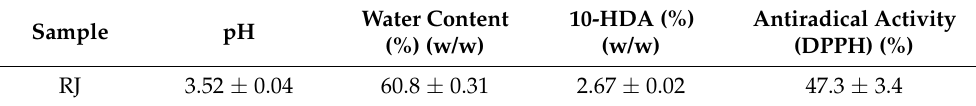
Table 1. Quality assessment of Lithuanian royal jelly—RJ (mean ± SD, n = 3).